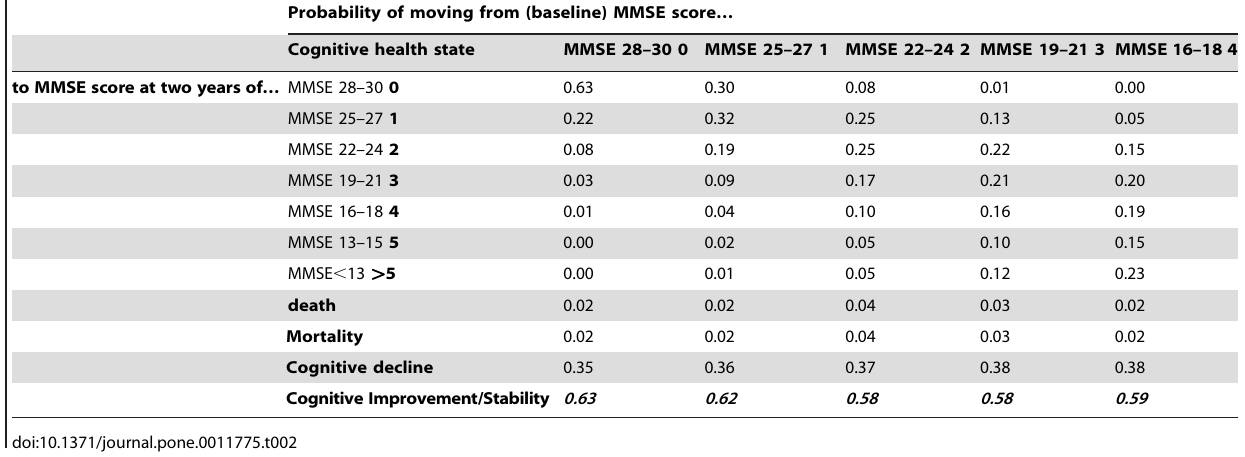
Table 2. Change in MMSE over two years - active group.